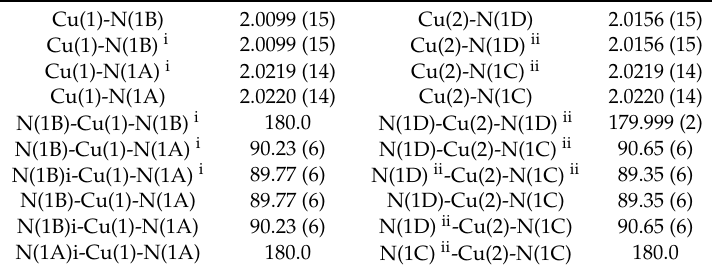
Figure 2. Numbering scheme for M1with atomic displacement ellipsoids drawn at the 50% probability level. Hydrogen atoms omitted for clarity ( A ). Hydrogen-bond pattern of the benzenetricarboxylic ion. The hydrogens involved in hydrogen bonds are shown only ( B ). Oxygen (red), nitrogen (dark blue), copper (light blue), hydrogen (green). Table 1. Selected bond lengths (Å) and angles (°) for M1.